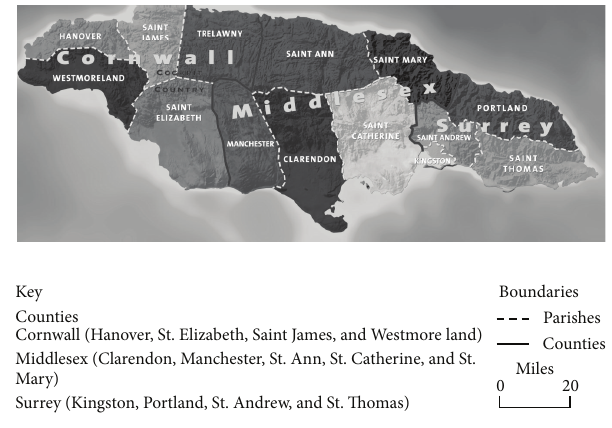
Figure 1: Parishes of Jamaica divided in the three counties: Corn- wall, Middlesex and